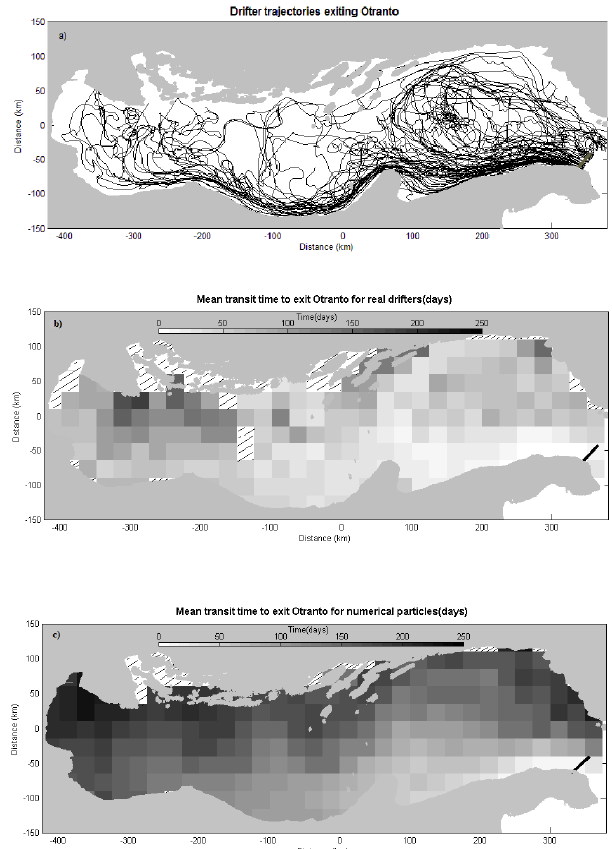
Fig. 3. Trajectories of the real drifters exiting the Adriatic Sea (a) . Geographical distribution of the mean transit times to exit via the western Otranto Channel (through section shown with black line) estimated from real drifters (b) and numerical particles (c)